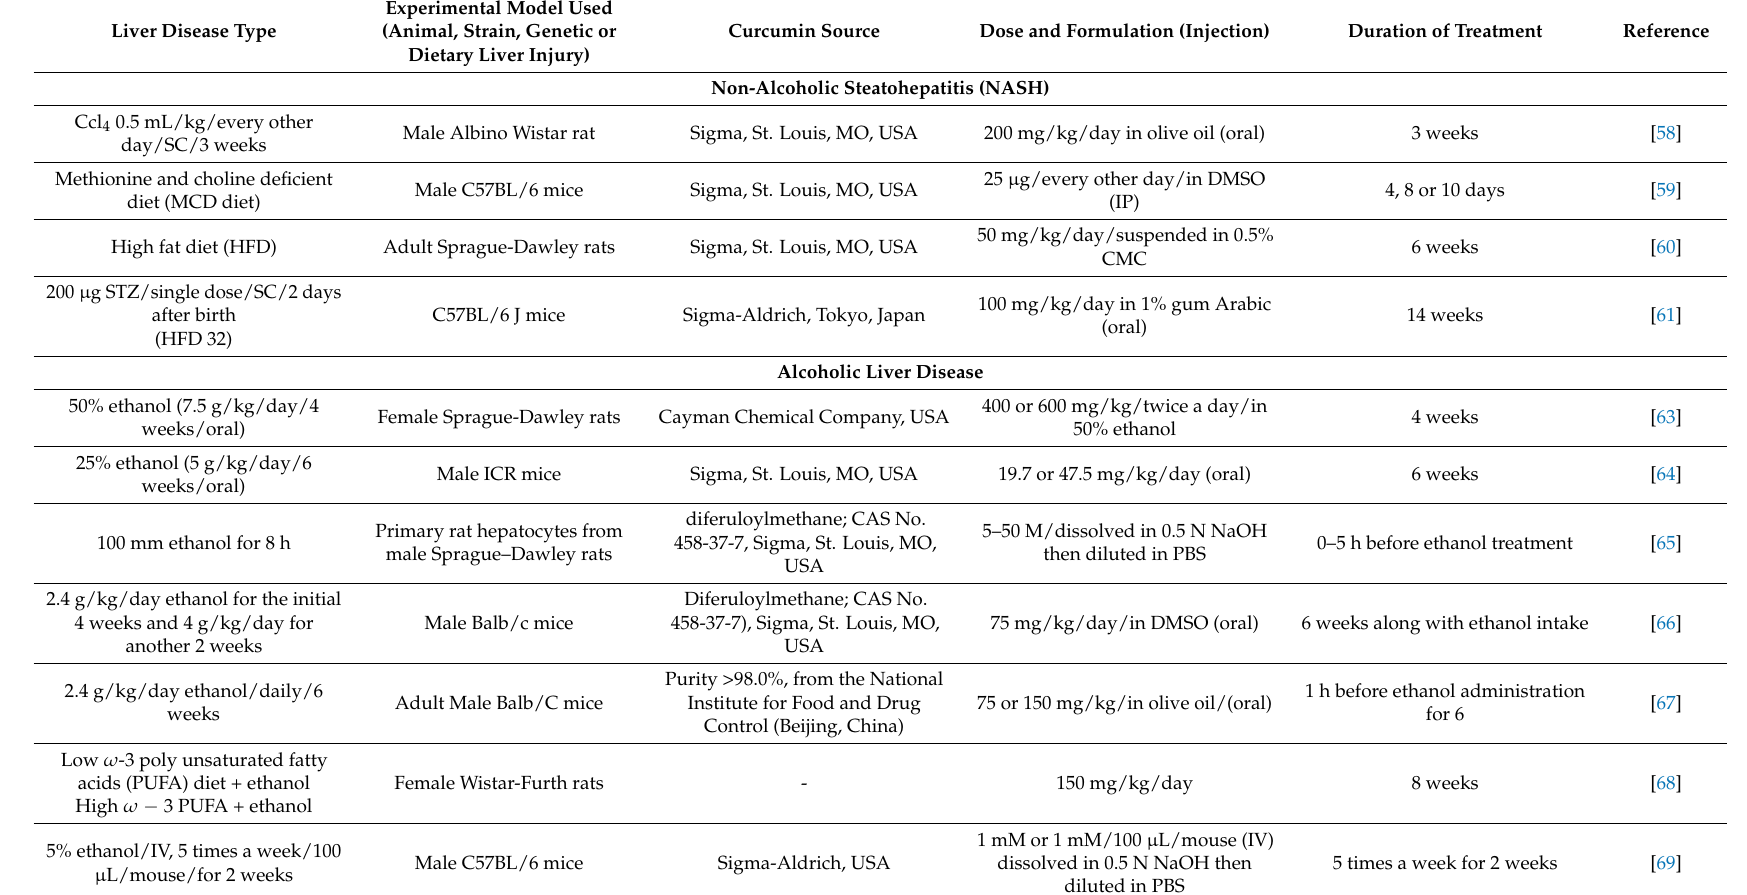
Table 1. Preclinical studies evaluating the effects of curcumin in the prevention/accelerating of oxidative associated liver